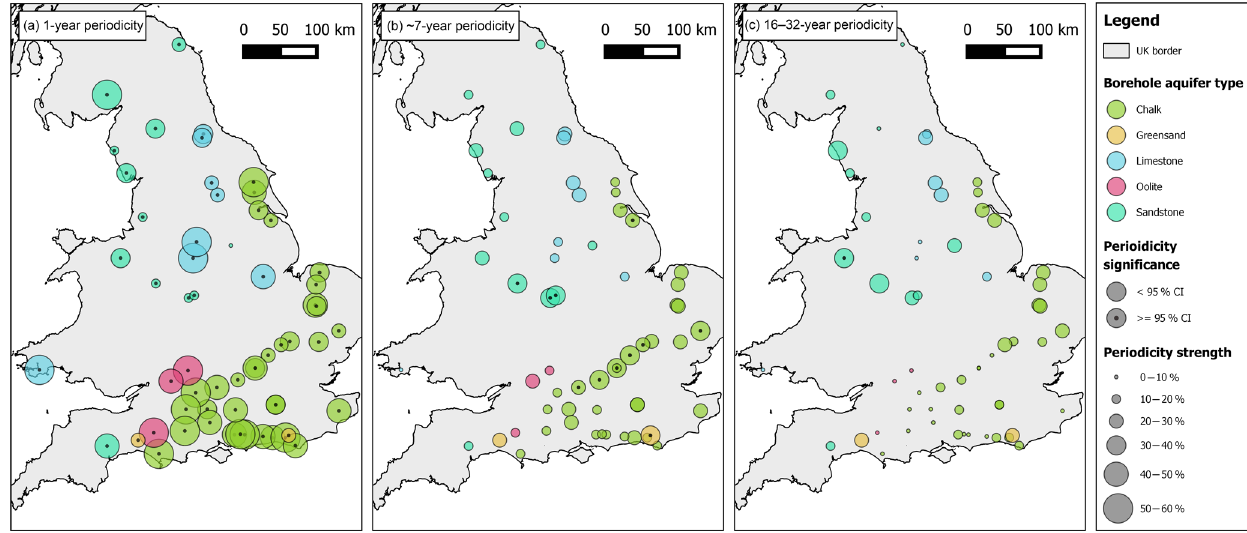
Figure 6. Maps showing strength (percentage of the original time series standard deviation) and significance of the (a) 1-year, (b) ∼ 7-year, and (c) 16–32-year periodicity bands. No periodicity strength was found to be above 60% of the original signal.